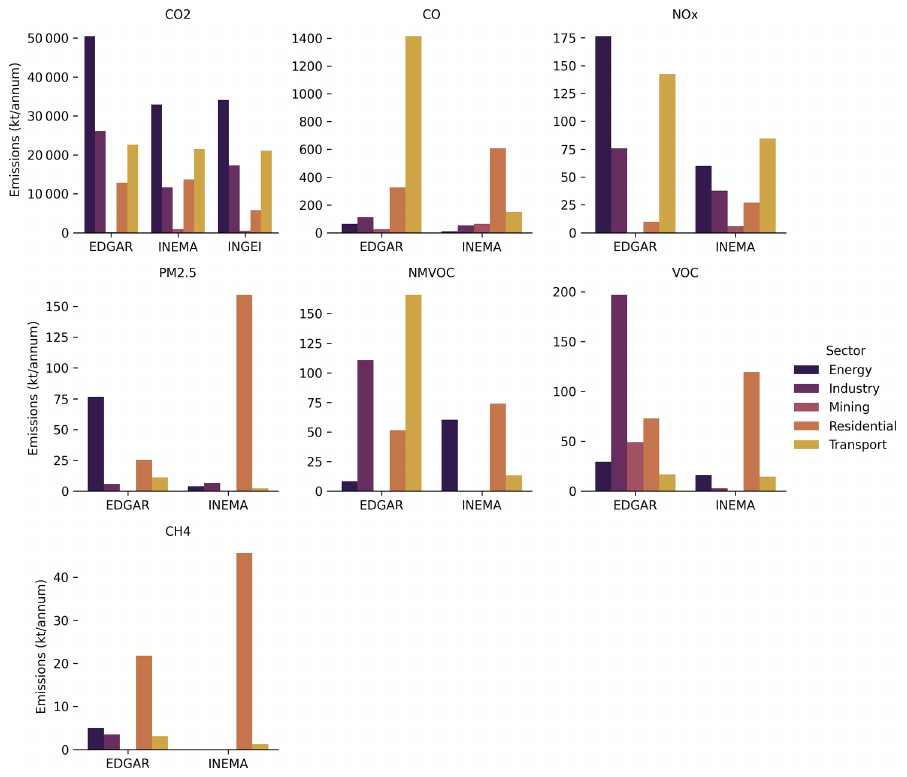
Figure 8. Total 2015 emissions in kilotons by pollutant and sector according to this work and EDGAR v5.0. Sectors considered in both inventories correspond to the classification proposed in IPCC (2006a) presented in Sect.